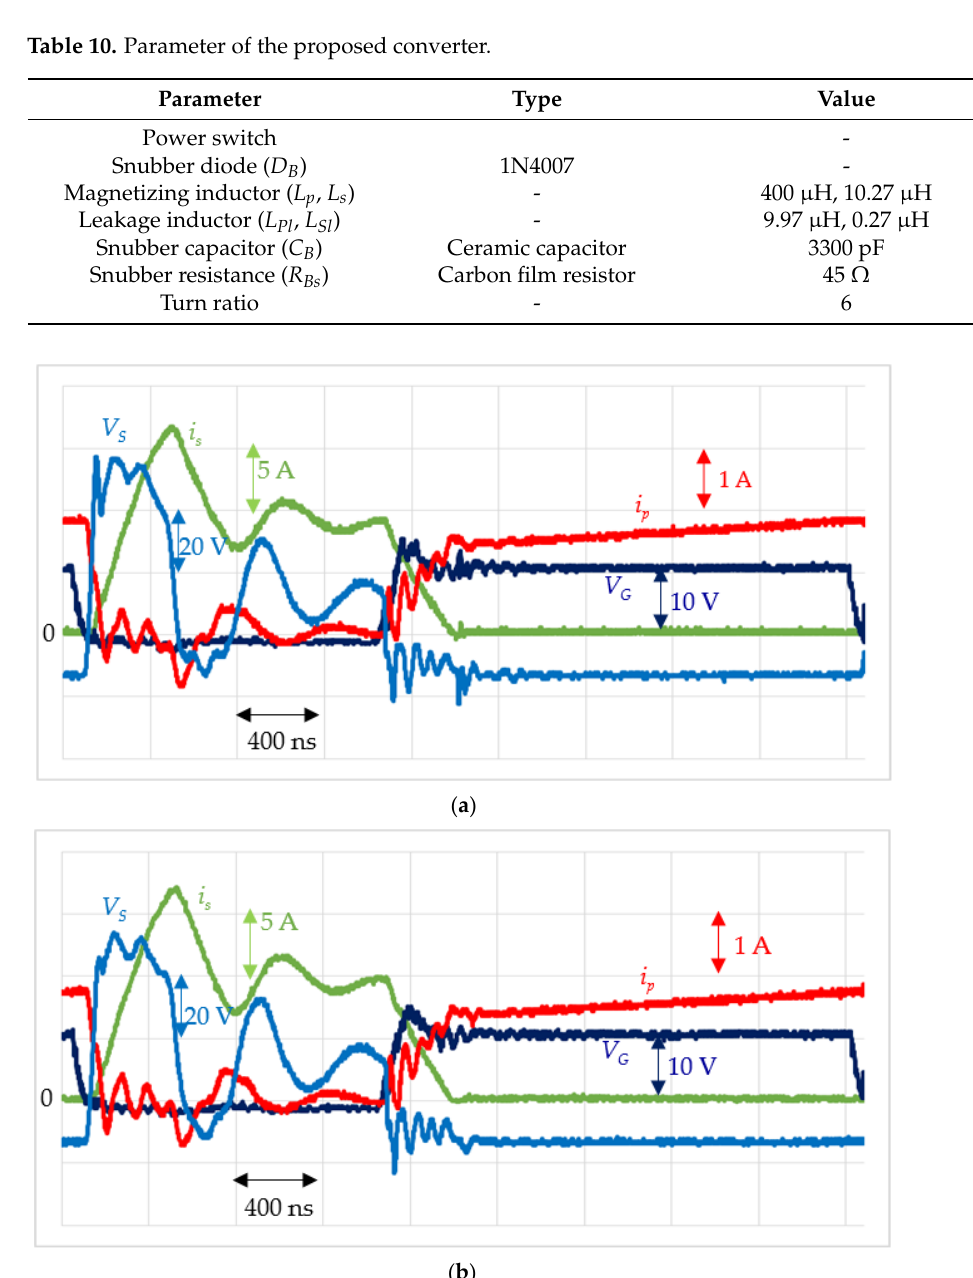
Figure 12. The response of oscilloscope screen dump. ( a ) diode (RFN10T2D), ( b ) D-mode GaN HEMT synchronous rectifier. Table 11. The time comparison in two different kinds of